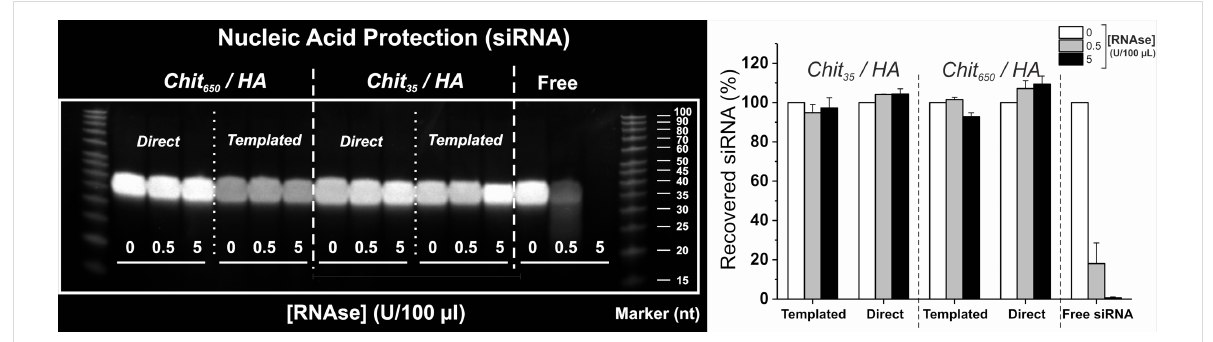
Figure 4: Protection of siRNA payload from enzymatic degradation. Left: PAGE analysis of entrapped siRNA after nanoparticle incubation with in- creasing concentrations of RNAse I, followed by quenching of nucleases, chitosanase and heparin treatment. Free, non-encapsulated siRNA was used as a control. The siRNA content in the particles was 25 wt % in relation to chitosan. Right: Plot of the band intensities relative to the signal of the negative control (no RNAse I treatment) for each formulation. Error bars represent standard deviation ( n = 3). Please note that results are normalized against the amount of siRNA released from formulations incubated with no RNase I (non-degraded) to account for any dilution factor or lose of materi- al, e.g., note the fainter bands detected for templated high- M W chitosan